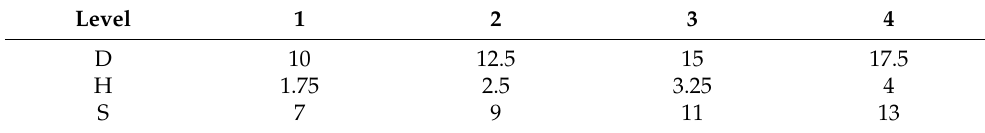
Table 4. Factor level parameters. Table 4 . Factor level parameters.